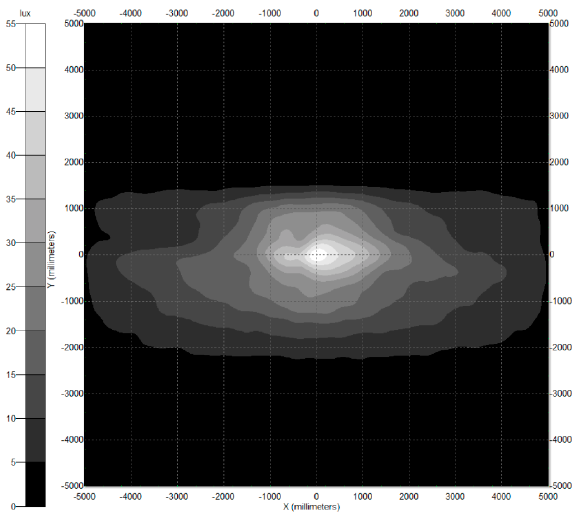
Figure 12. Simulated illuminance distribution of the high-beam light generated by the proposed headlamp. Table 3. Comparison of the simulated and measured illuminances of the novel single headlamp with the corresponding values set by ECE R112 for high-beam light.